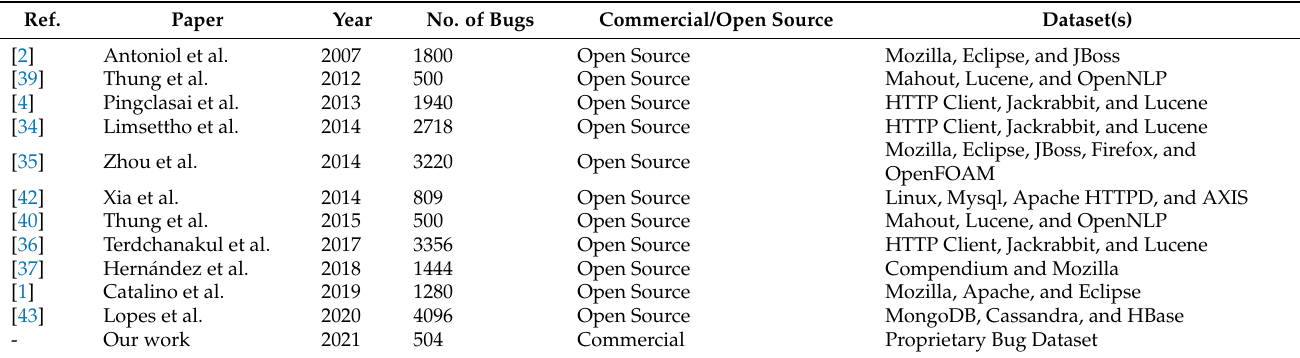
Table 12. Comparison of automatic bug classification studies.